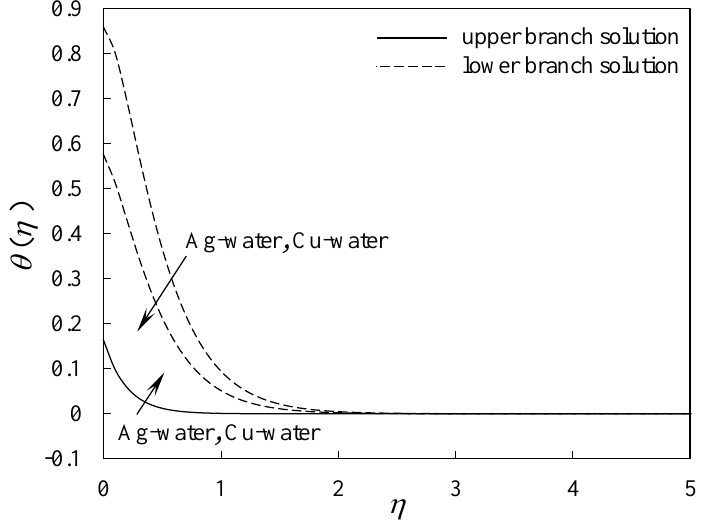
    when  = −1, N = 1, K = 1, and M = 1. Figure 22. Temperature profiles θ ( η ) when λ = − 1, N = 1, K = 1, and M =